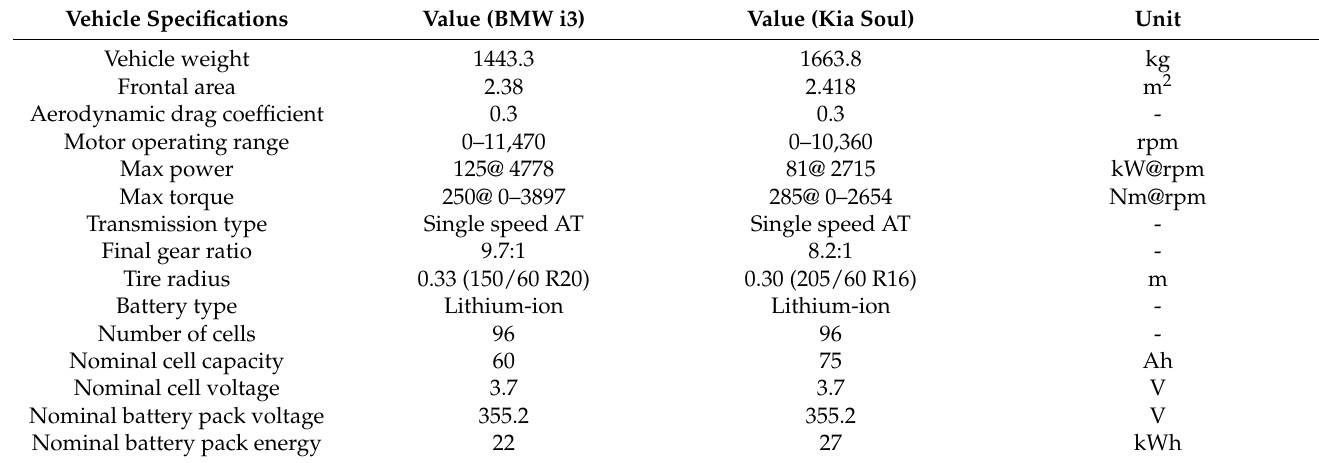
Table 1. Technical specification of two considered BEVs